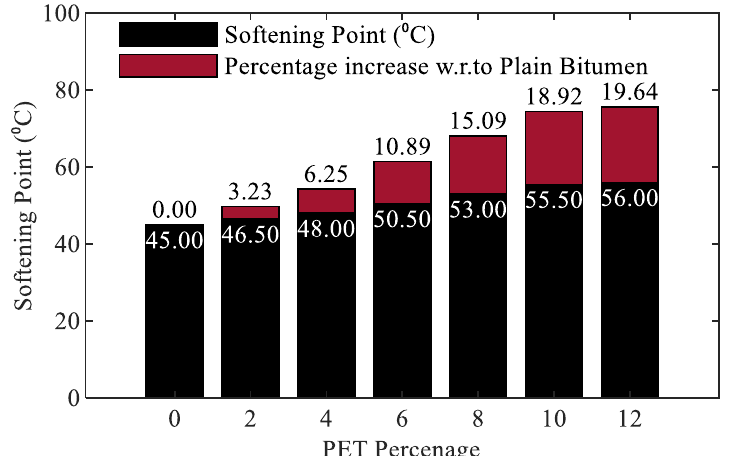
Fig. 17 Variation of softening point with PET